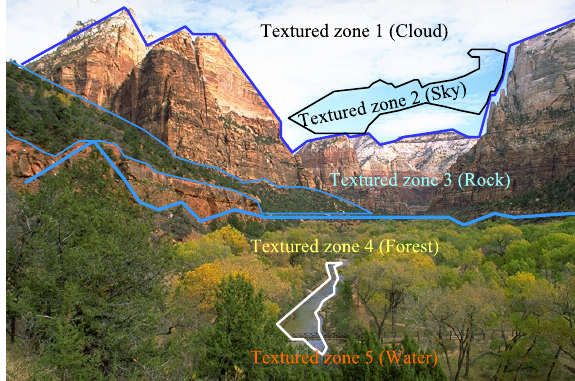
Figure 3. Example of segmentation texture zone in a natural